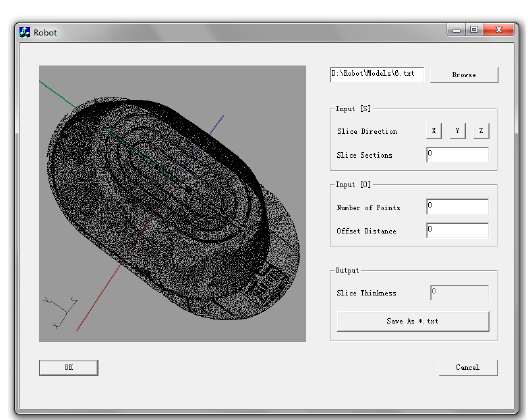
Figure 10. The Curved Surface Modeling Diagram of the Workpiece.